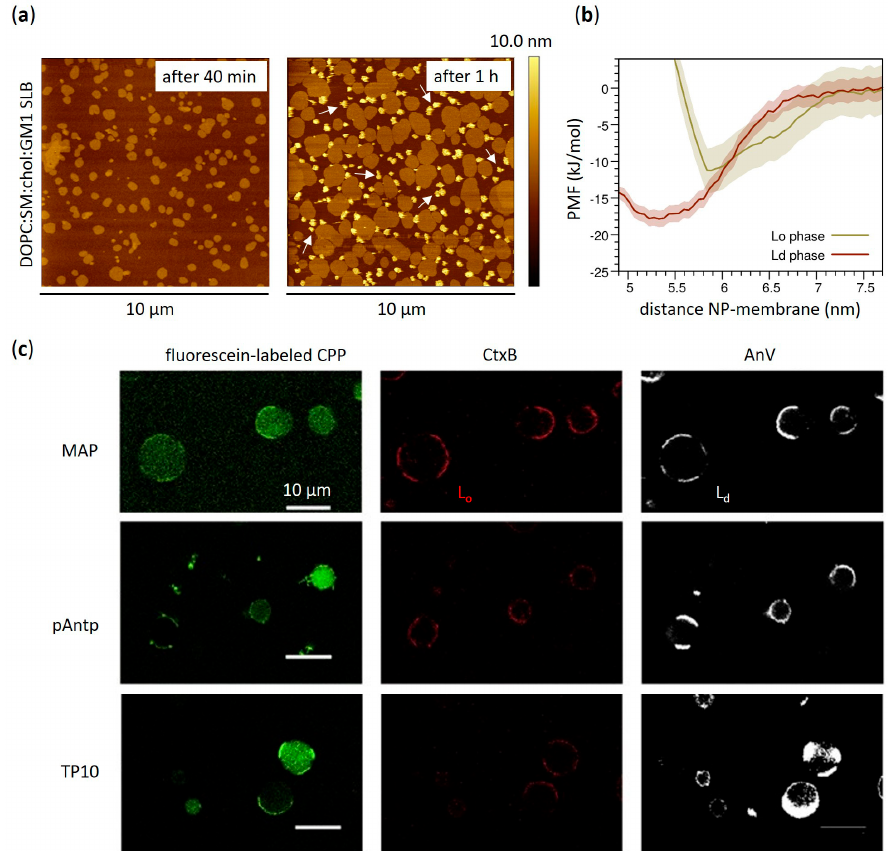
Figure 2. Amphiphilic AuNPs and amphiphilic peptides: a common affinity for the disordered domains of phase − separated lipid membranes. ( a ) Phase − separated SLBs containing 1,2-dioleoyl-sn-glycero-3-phosphocholine (DOPC), sphingomyelin (SM), cholesterol and ganglioside GM1 (63:31:1:5 molar ratio) imaged in liquid by atomic force microscopy (AFM) after addition of ~3 nm MUS:OT AuNPs (40 min and 15 h). After hours, large clusters of amphiphilic AuNPs (white arrows) slowly formed on the darker disordered phase and at the edges of the lighter (i.e., higher) ordered lipid domains. ( b ) Potential of mean force (PMF) profiles calculated for the adsorption of a single MUS:OT AuNPs on the surface of the L d and L o phase. The L d phase, with a binding free energy of ~18 kJ/mol (~9kBT), is favoured over the L o phase (~11 kJ/mol, ~5 kBT). ( c ) Giant plasma membrane vesicles (GPMVs) derived from rat basophilic leukemia cells incubated at low temperature with three examples of fluorescein-labeled CPPs—i.e., MAP (model amphipathic peptide), penetratin (pAntp) and transportan 10 (TP10) (green). All these CPPs are amphipatic and contain Lys or Arg residues. L o and L d phases are labeled with AF594-labeled cholera toxin B subunit (CtxB, red) and AF647-labeled annexin V (AnV, pseudocolored as white), respectively. ( a,b ) contain images by Canepa et al. [44] reprinted with minor modifications under a CC BY-NC 3.0 license with permission from the Royal Society of Chemistry. ( c ) is reproduced and adapted with permission from Säälik et al. [81]—Copyright © 2022 Elsevier B.V. All rights reserved.